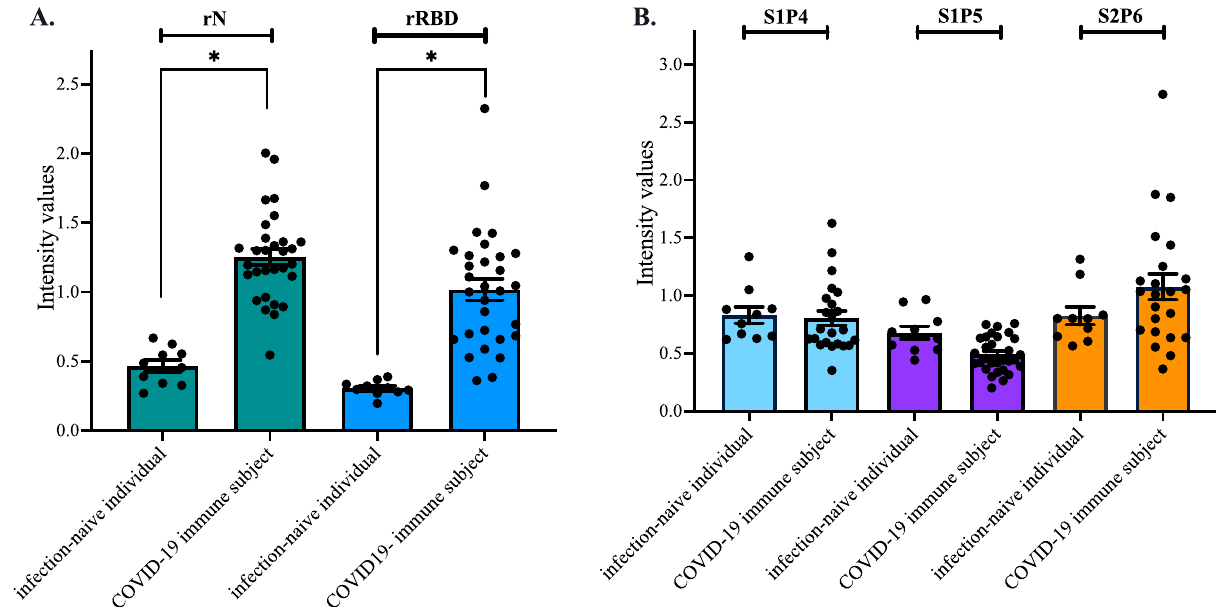
Figure 6. Antigenic reactivity of the synthetic peptides with human serum-specific SARS-CoV-2 antibody. Serum samples from COVID-19 recovered patients ( n = 30) (Table S2) and ten infection- naïve individuals ( n = 10) (Table S3) were tested for the antibody reactivity against the N and RBD proteins through indirect ELISA ( A ), or the S1P4, S1P5, and S2P6 peptides through synthetic peptide-based ELISA ( B ). The intensity values of serum samples were measured at O.D. 450 nm. In ( A ), the serum samples at dilution 1:100 were assayed for the detection of antibodies against SARS-CoV-2 N and spike proteins by indirect ELISA using recombinant rN and rRBD proteins (1 µg.ml −1 ) for antigen-based antibody capture. The intensity values of serum samples were measured at O.D. 450 nm. Unpaired t tests between infection-naïve individuals and COVID-19 immune subjects were performed and statistically significant comparisons are shown as * p < 10 –4 . In ( B ), The serum samples ( n = 23) among the COVID-19 recovered patients who developed higher anti- RBD antibody titers were assayed for the detection of antibodies against the S1P4, S1P5, and S2P6 peptides (200 ng.ml −1 ) through synthetic peptide-based ELISA at serum dilution 1:50. The results are the mean (± SEM) of three replicates. The intensity values of serum samples were measured at O.D. 450 nm. Unpaired t tests between infection-naïve individual and COVID-19 immune subject were performed and differences between experimental points considered as non-statistically significant ( p > 0.05) are not